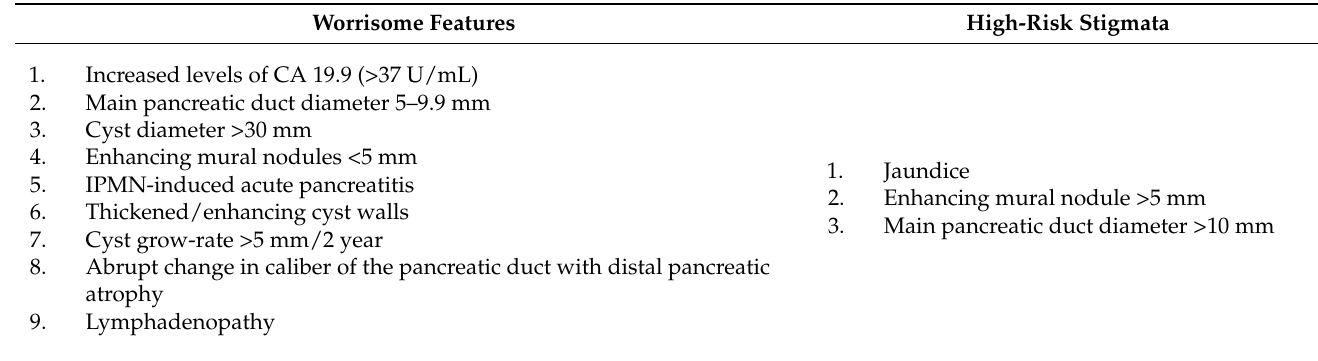
Table 1. Worrisome features and high-risk stigmata for IPMN according to the 2017 Fukuoka Consensus Guidelines. Worrisome Features